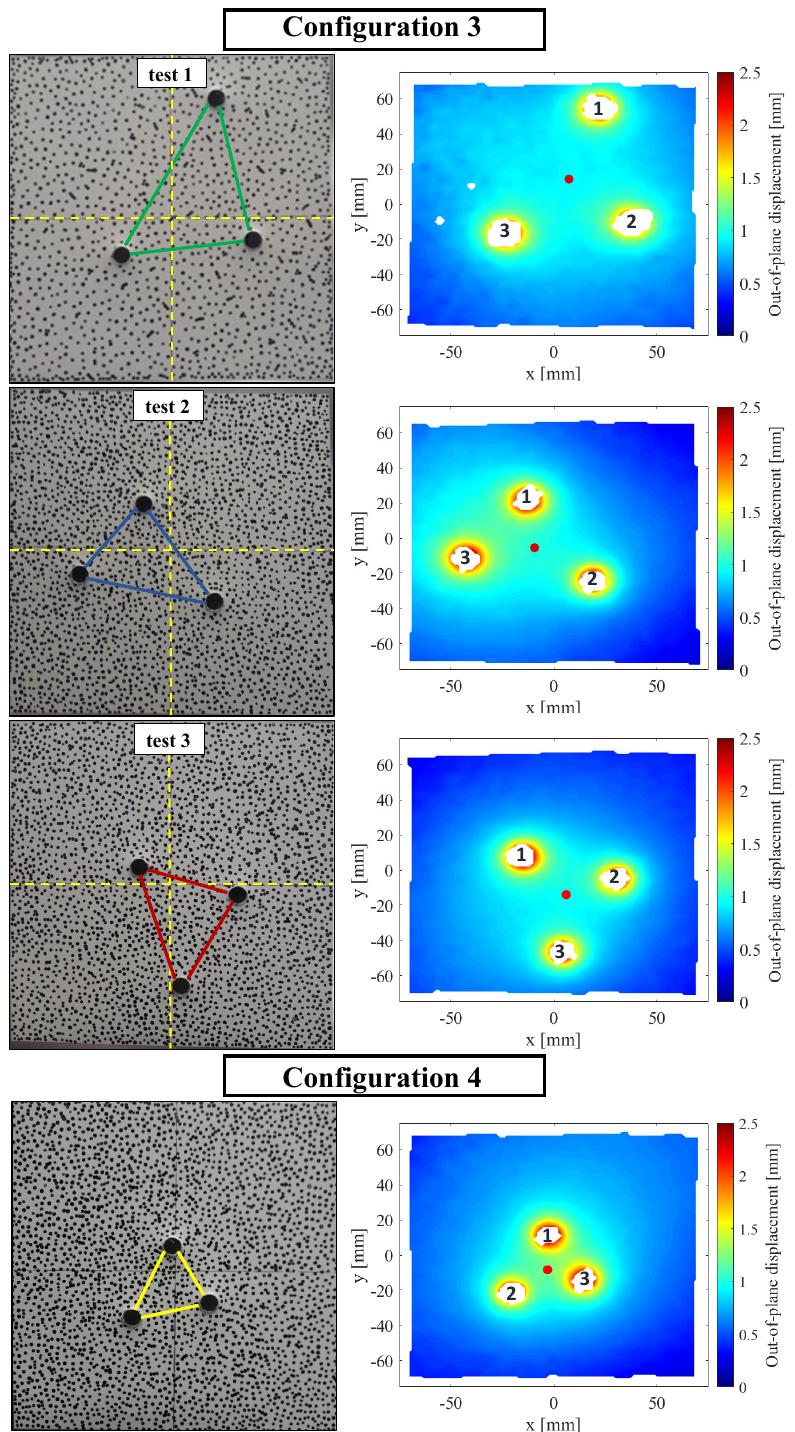
Figure 11. Plane view of the different tests of configurations 3 and 4 after full FSP perforation and their corresponding out-of-plane displacement